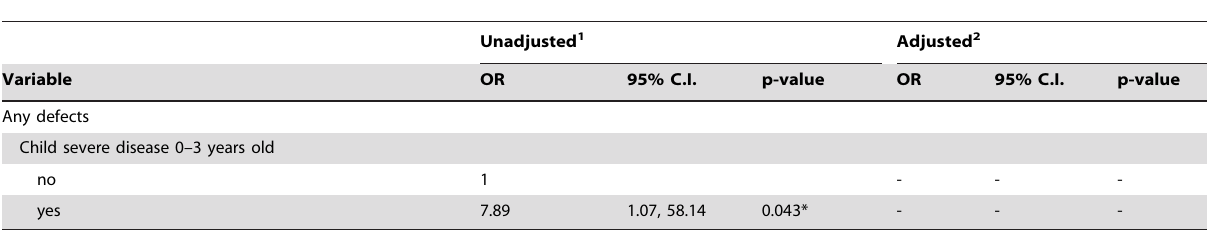
Table 3. Multinomial logistic regression of